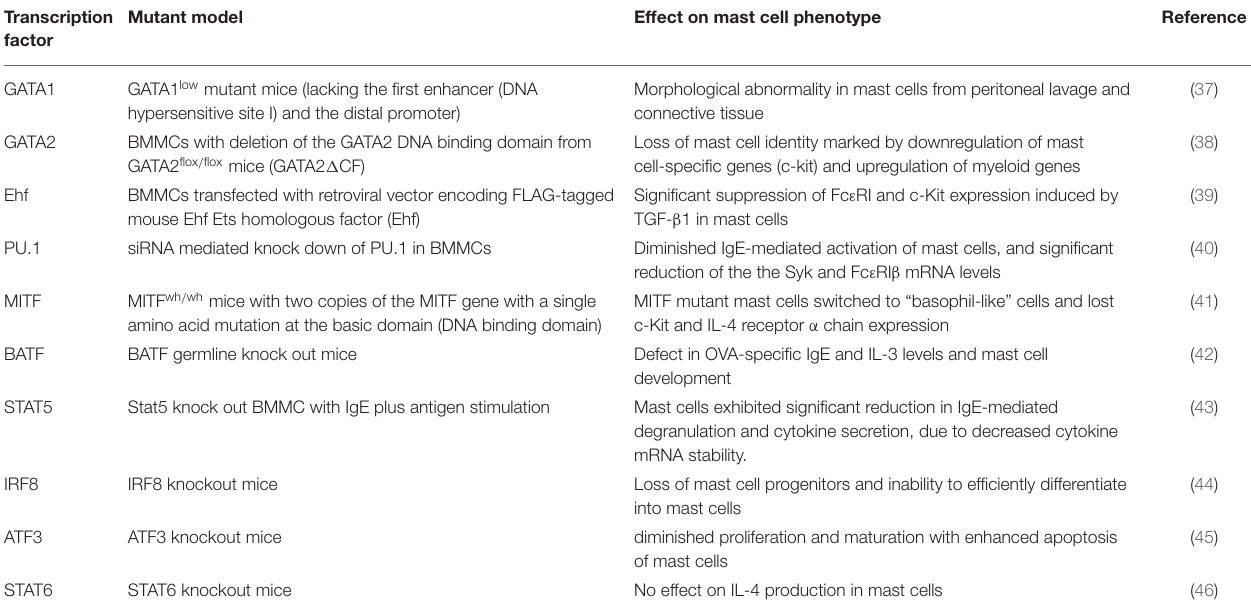
TABLE 1 | Mast cell phenotypes in transcription factor mutant